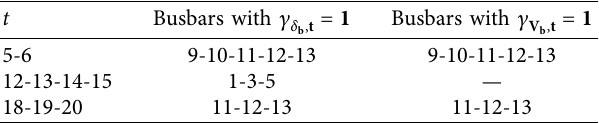
Table 9: Values of binary coefcient c in scenario 4.